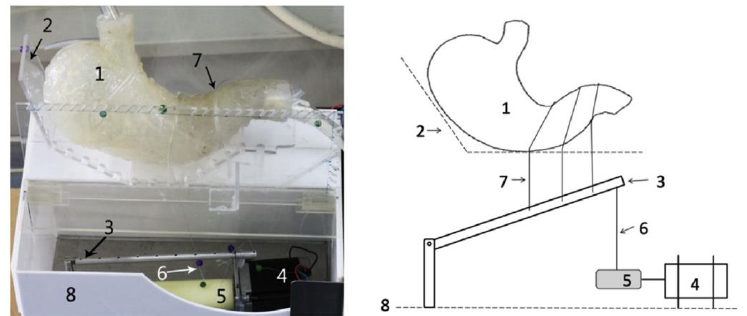
Figure 13. Photograph ( left ) and schematic ( right ) of the human stomach model proposed by Chen et al. and reprinted from Reference [108] with permission from Elsevier. Explanation of numbers as stated by the authors: (1) the human stomach model, (2) plexiglass support, (3) pull rod, (4) step motor, (5) spindle, (6) wire, (7) contractive ropes, (8) base box.